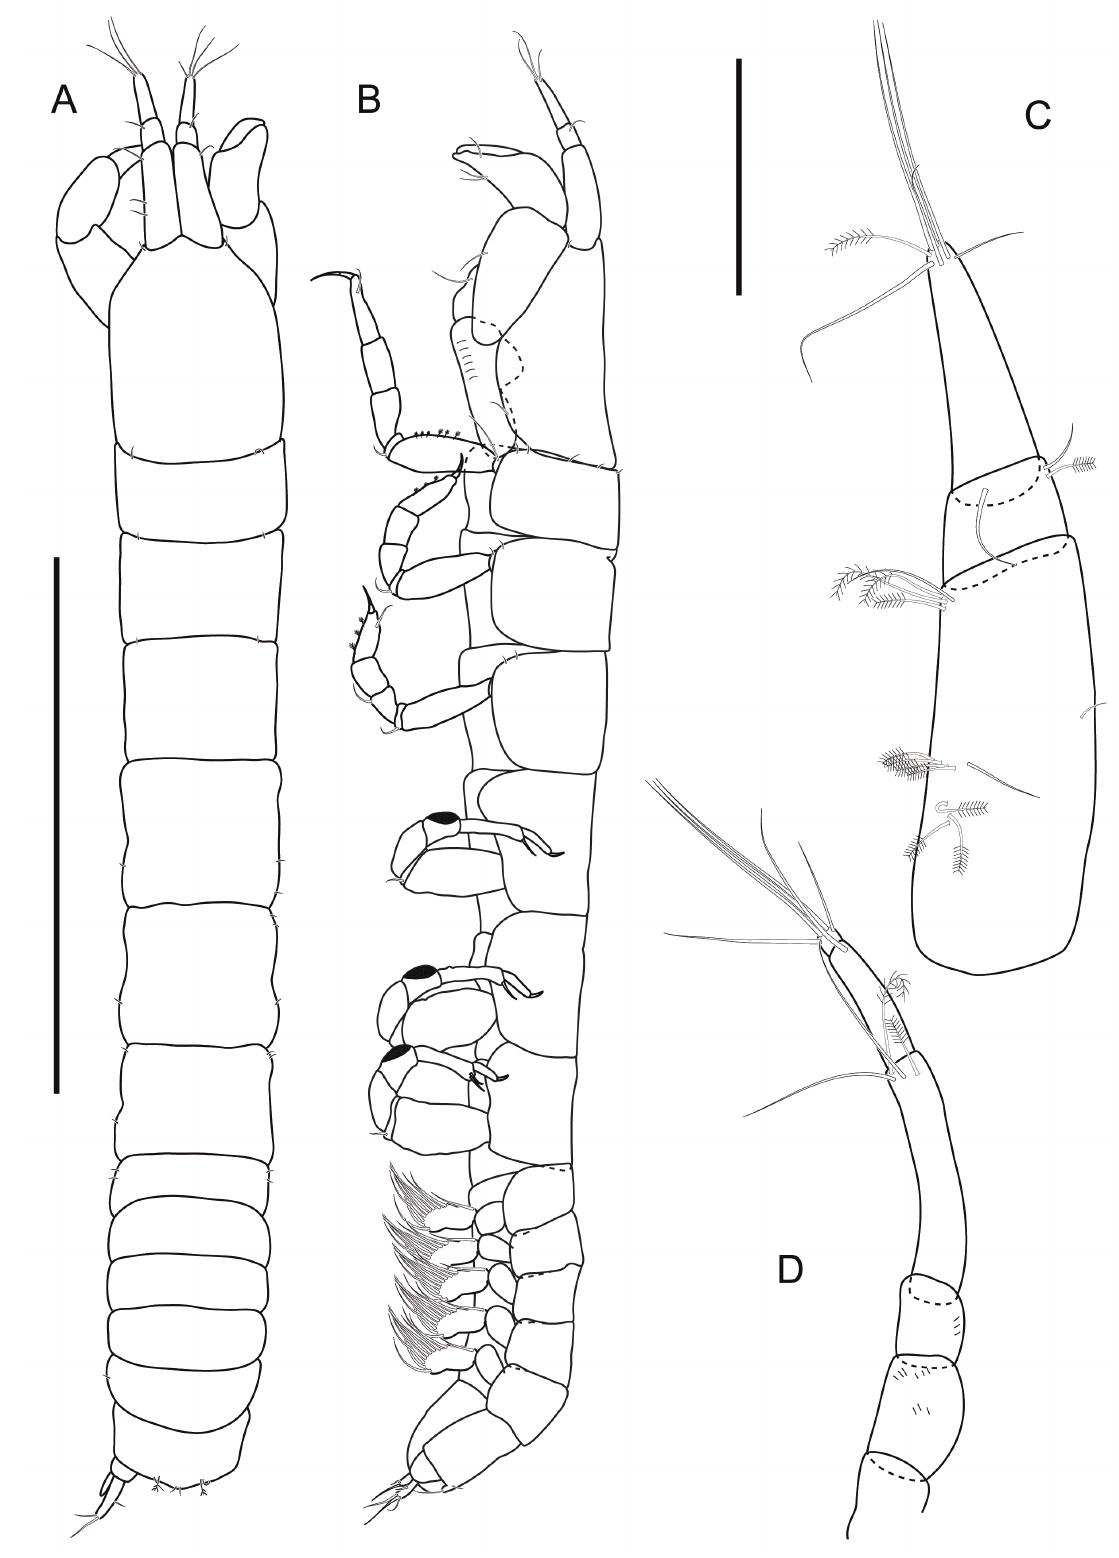
Fig. 5. Typhlotanais longiseta sp. nov., paratype (MZUSP 38015), ♀, dissected. A . Dorsal view. B . Lateral view. C . Antennule. D . Antenna. Scale bars: A–B = 1 mm; C–D = 0.1